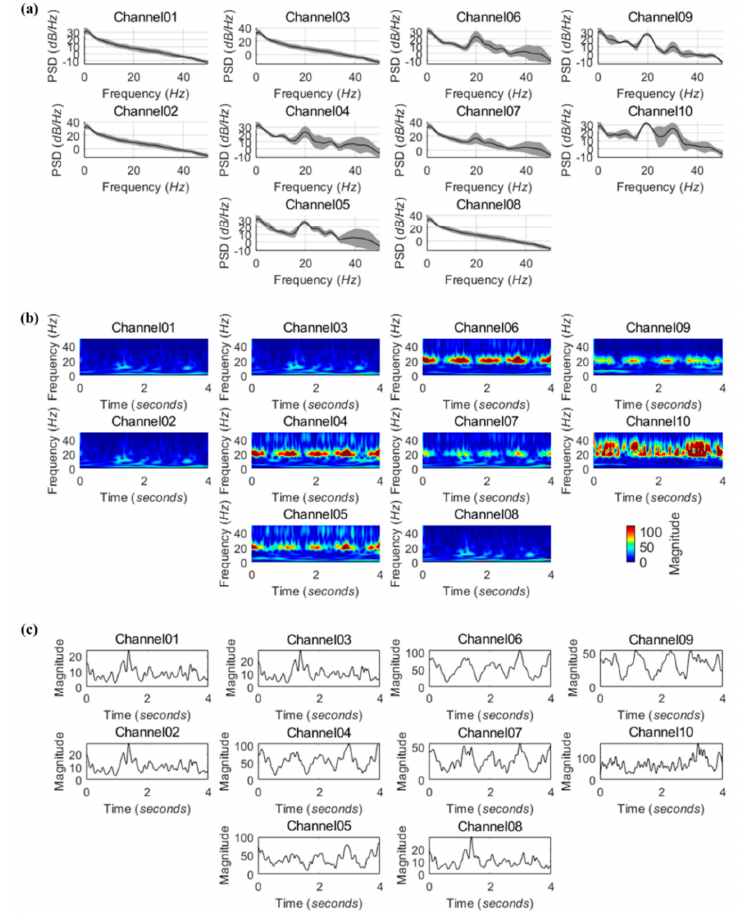
Figure 8. Frequency components of ECoG signals recorded from a rat olfactory bulb via 10 channels of MEA during respiration. ( a ) Averaged power spectral density estimates derived from 20 epochs. Shaded areas indicate the standard deviation; ( b ) Representative time-frequency distributions extracted from a single epoch; ( c ) Time courses of spectral power in the beta frequency band during a single epoch.